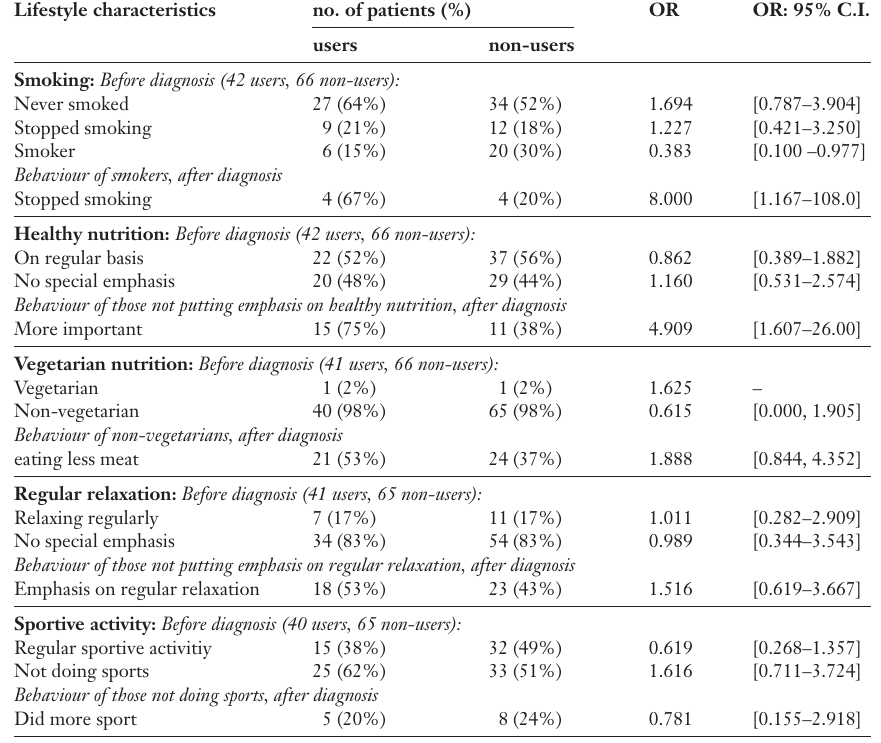
Table 7 Lifestyle before and after the diagnosis of